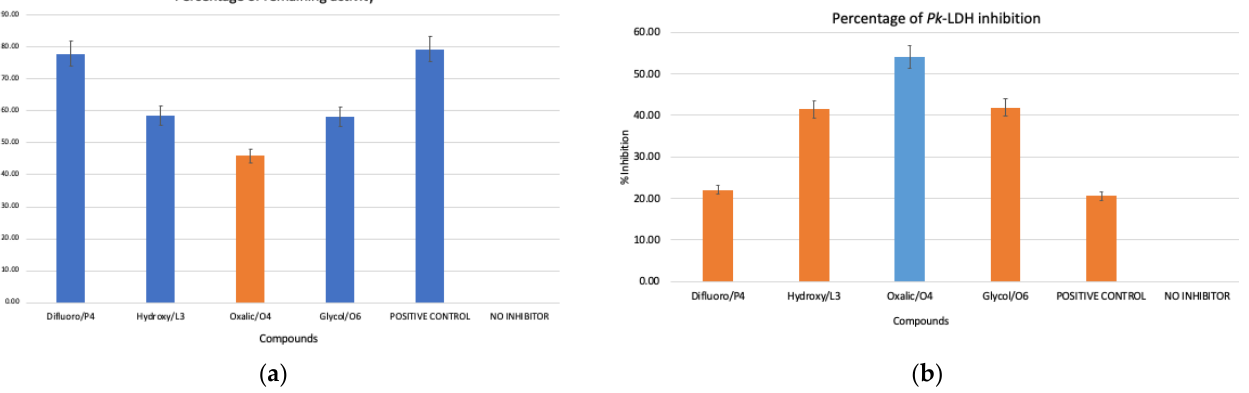
Figure 1. ( a ) Specific activities of Pk ‐ LDH in the presence of the indicated compounds: P4: 3,3 ‐ difluoropyrrolidine hydrochloride, L3: 3 ‐ hydroxytetrahydrofuran, O4: oxalic acid, O6: glycolamide, positive control: OXM and no inhibitor: negative control. ( b ) Percentage of Pk ‐ LDH inhibition with different compounds labelled the same as in ( a ). Compound O4 showed the highest inhibition at 54.12%.